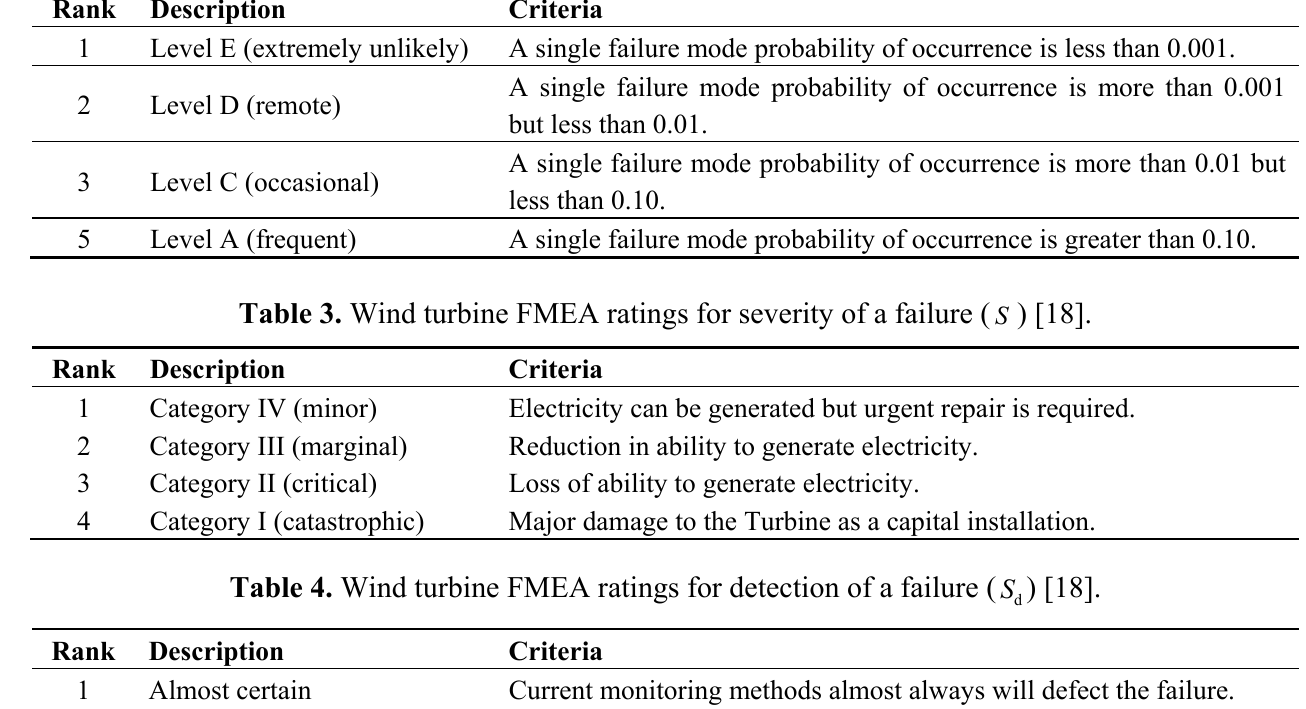
Table 2. Wind turbine FMEA ratings for occurrence of a failure (